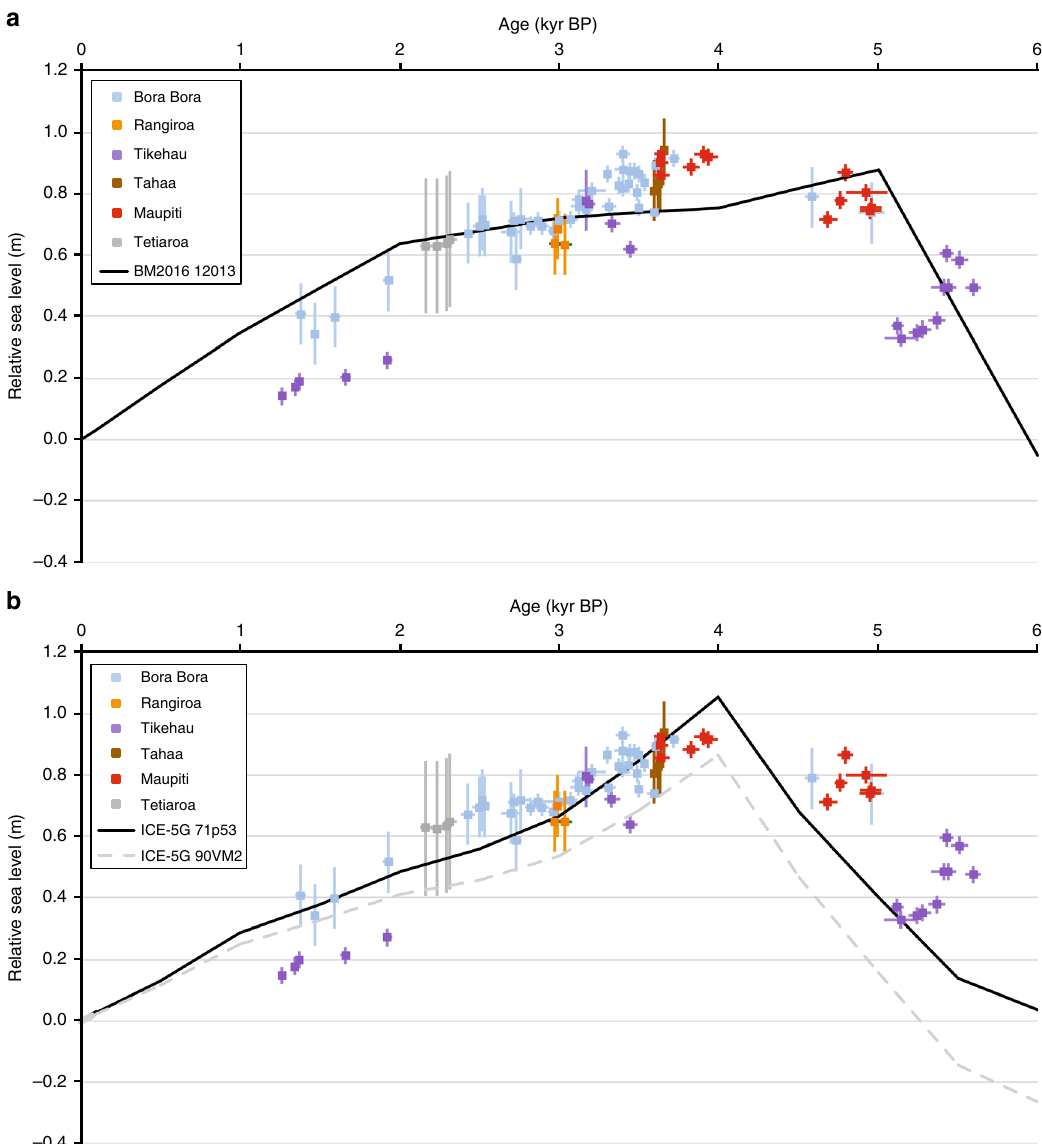
Fig. 7 Comparison of observations and predictions of sea-level change for French Polynesia. a Reconstructed RSL compared to model output (black line) based on the BM2016 ice model and the viscosity model that optimised the data-model fi t (see main text). In order to remove spatial variability associated with GIA, data were corrected to the location of Bora Bora using these model parameters (see 'Methods' section). b Same as in a except that the ICE-5G ice model was used with two viscosity models; one that optimised fi ts to the French Polynesian data (see main text; black line) and the VM2 model (dashed grey line 50 ). Error values for ages and elevations are 2-sigma (see 'Methods' section and Supplementary Table